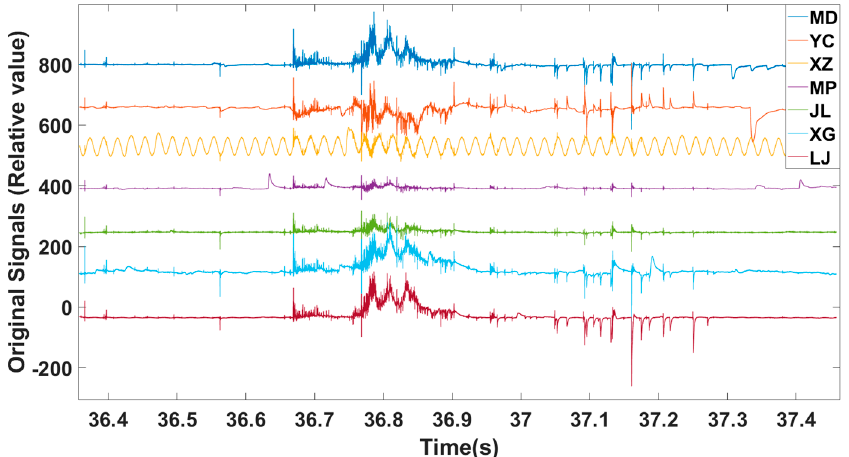
Figure 2. Original electric field signal over time from the seven stations for IC flash 001136.